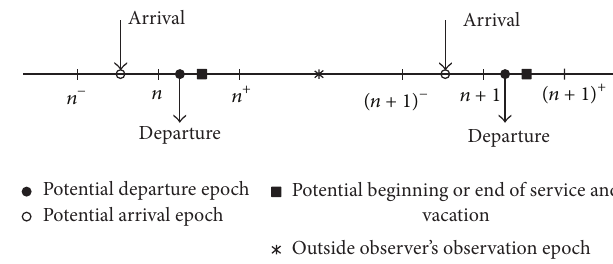
Figure 1: Various time epochs in a late arrival system with delayed access